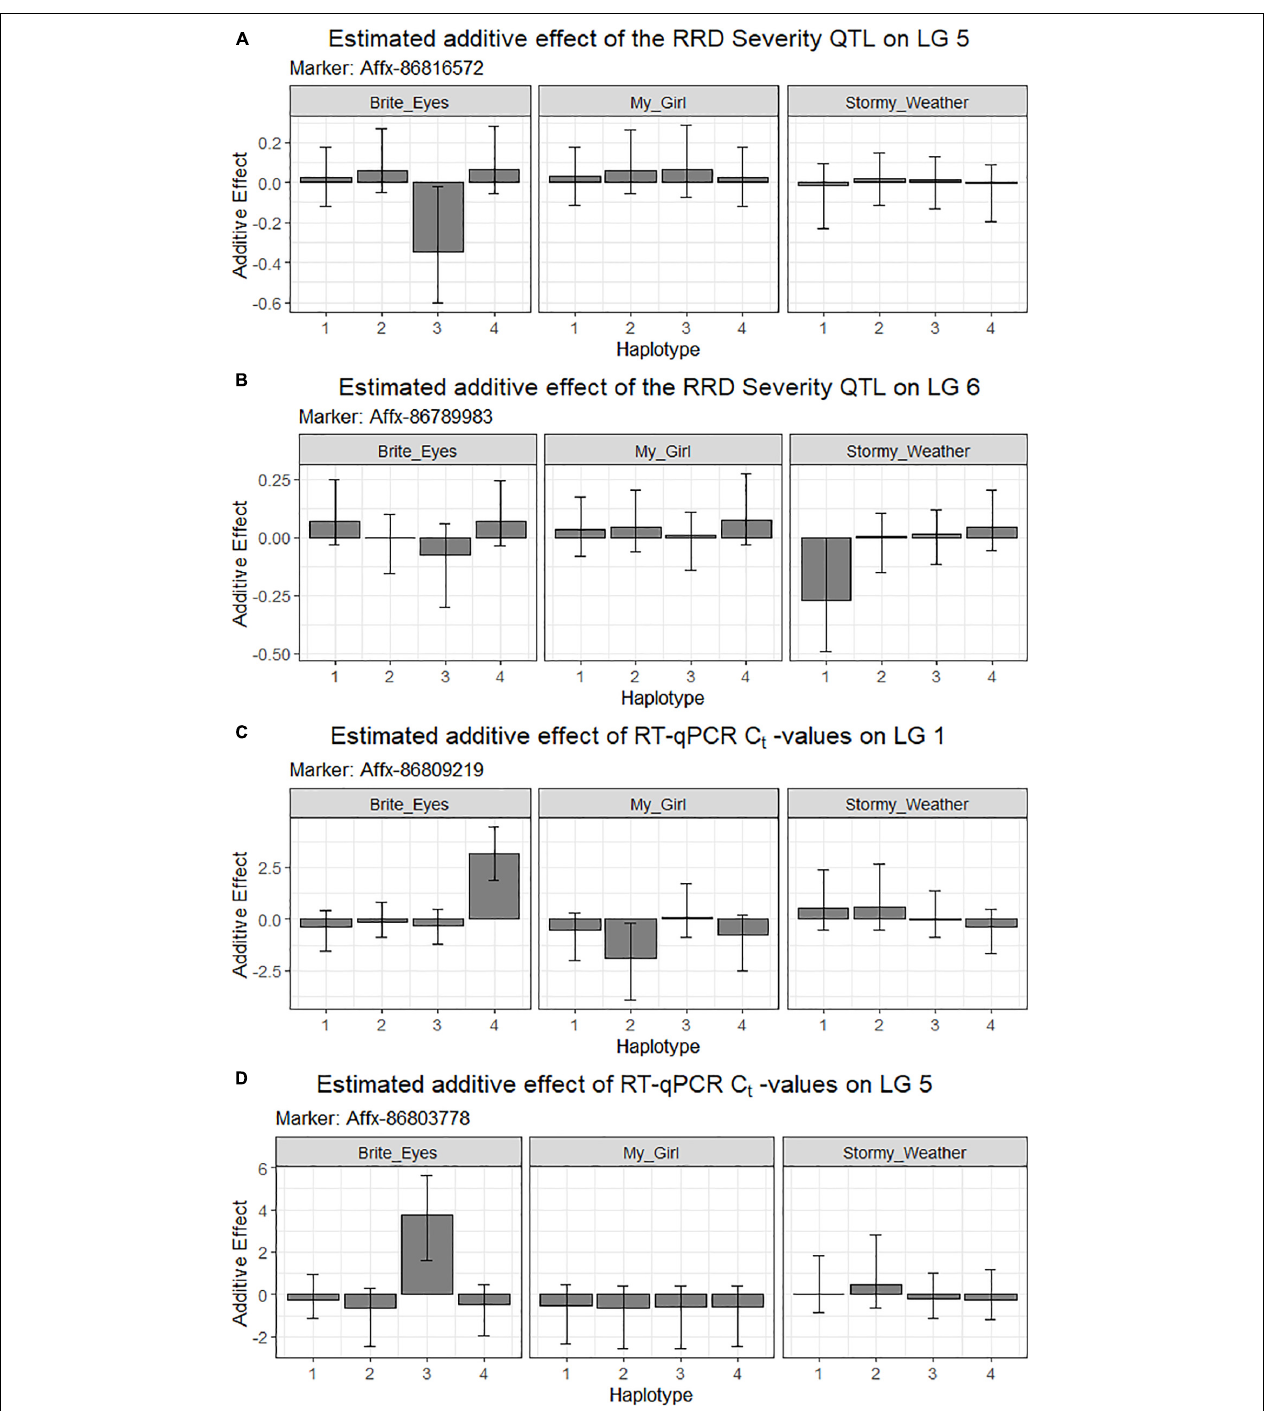
FIGURE 7 | Estimated additive allele effects for (A,B) RRD severity and (C,D) RT-qPCR for RRV in two interconnected tetraploid garden rose mapping populations estimated from the R-software diaQTL. On the x-axis are the parental homologs, and the y-axis is the estimated additive effect of the parental homolog at the QTL position on the phenotype. For example: (A) the presence of the 3rd homolog in an individual has an estimated negative effect on the RRD severity